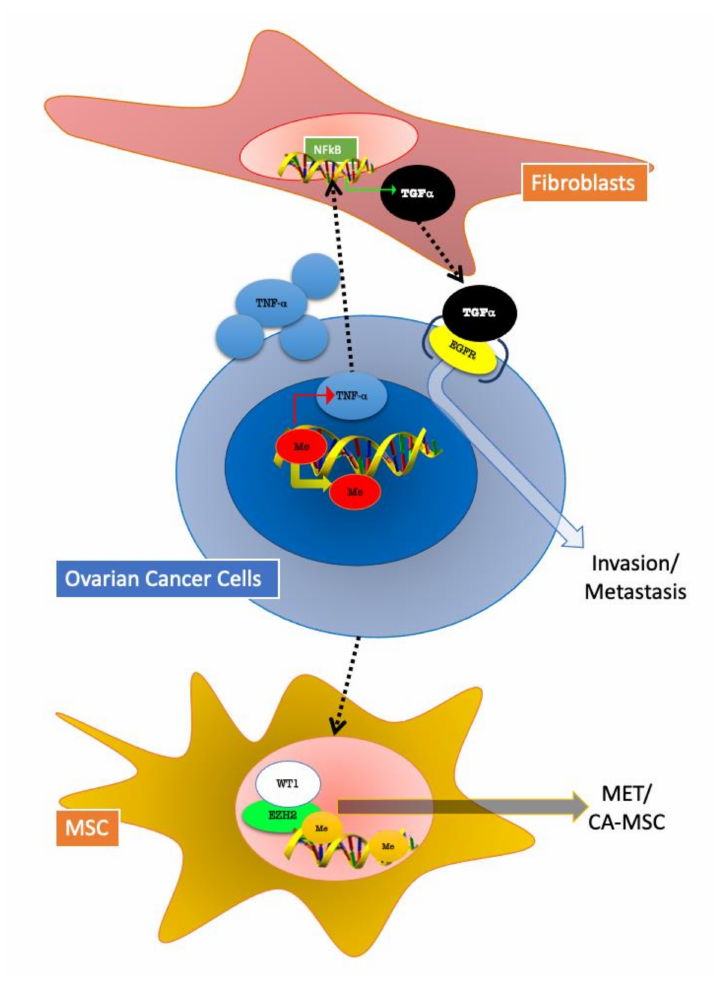
Figure 3. Epigenetic changes involved in tumour–stroma crosstalk in ovarian cancer (OC) cells. Fibroblasts and MSC (mesenchymal stem cells) can both influence and be influenced by OC cells. In both represented mechanisms, epigenetic modifications play a pivotal role. Fibroblasts in OC TME are involved in a TNF α /TGF- α /EGFR (epidermal growth factor receptor) loop activated by DNA hypomethylation, which sustains cancer cells invasion and metastasis. OC cells mediate mesenchymal to epithelial transition (MET) in MSC by the activation of the epigenetic regulator EZH2 (enhancer of zeste homolog